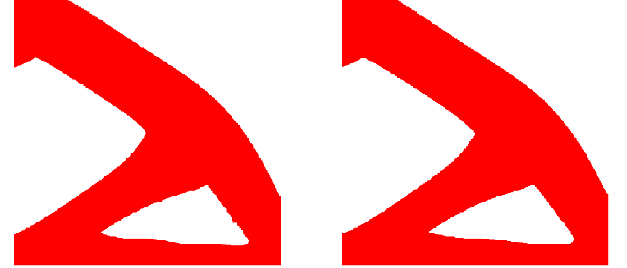
Figure 11. The final topologies obtained for von Neumann (left) and Moore (right) neighborhoods.